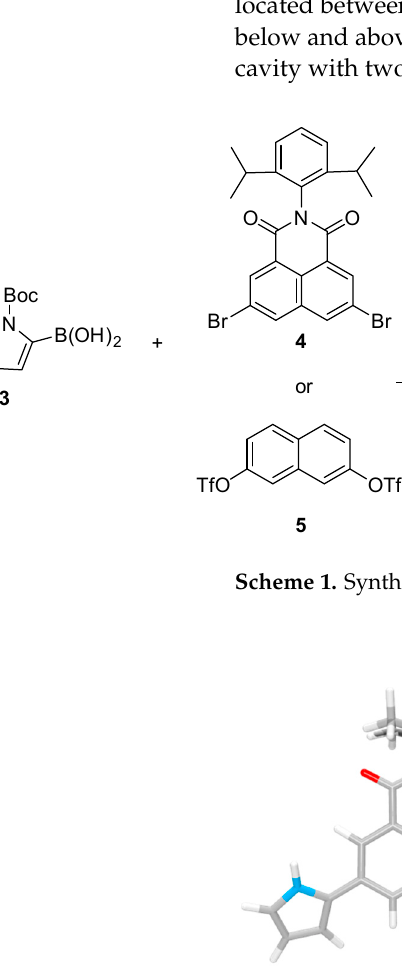
were computed to be − 28.08 kcal/mol and − 23.58 kcal/mol, respectively, while receptor 2 kcal/mol of binding energies, respectively (Figure 3). These values reflect that receptor 1 binds the fluoride and the chloride anion more strongly by 5.47 kcal/mol and 5.12 kcal/mol, respectively, than receptor 2 . This finding is attributable to the high acidity of